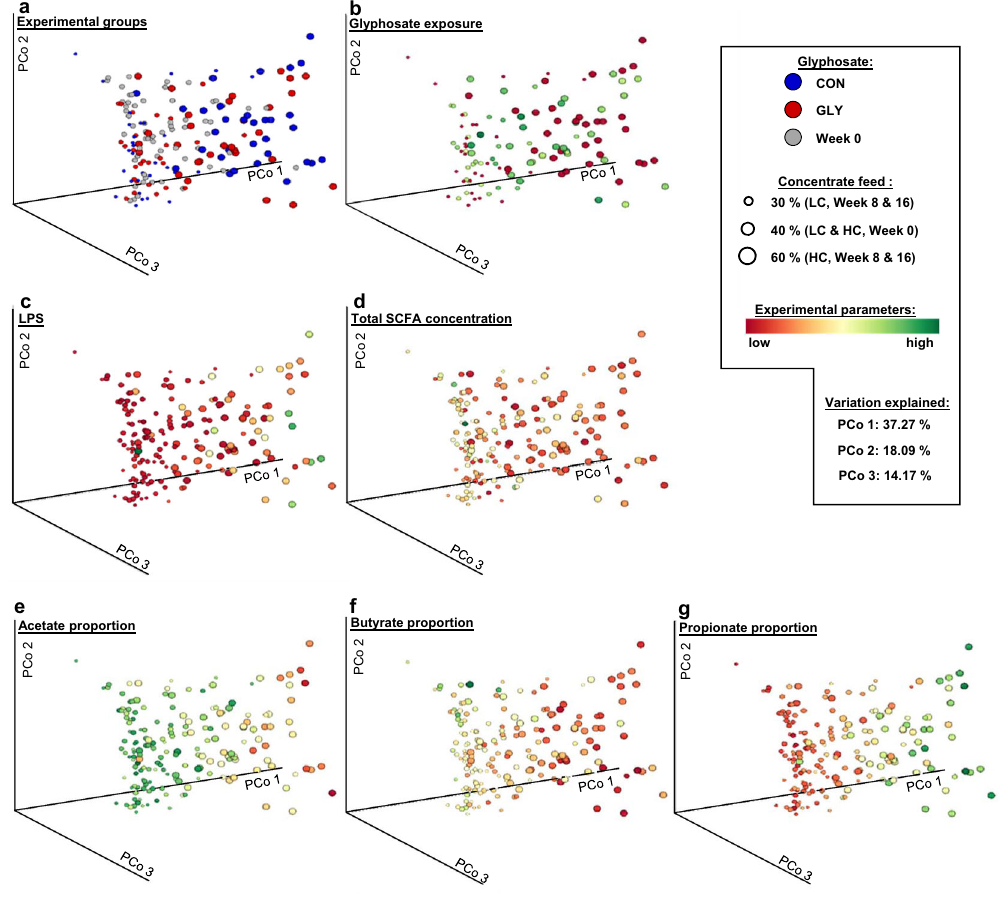
Fig. 3 Principal Coordinate Analysis of the rumen microbial community based on weighted UniFrac distance. Displayed are different colorations of the identical principal coordinate analysis (PCoA) analysis of the rumen microbial community based on weighted UniFrac distance. Coloration in discrete scaling: a experimental groups. Colorations in continuous scaling: b glyphosate exposure in weeks 8 and 16, c concentration of total ruminal short-chain fatty acids (SCFAs), d concentration of ruminal LPS, e – g proportions of acetate, butyrate and propionate among ruminal SCFAs. CON: control group, GLY: group with glyphosate contaminated diet, Week 0: values before feeding CON or GLY diets, CFP: concentrate feed proportion, LC: low CFP, HC: high CFP, PCo: principal